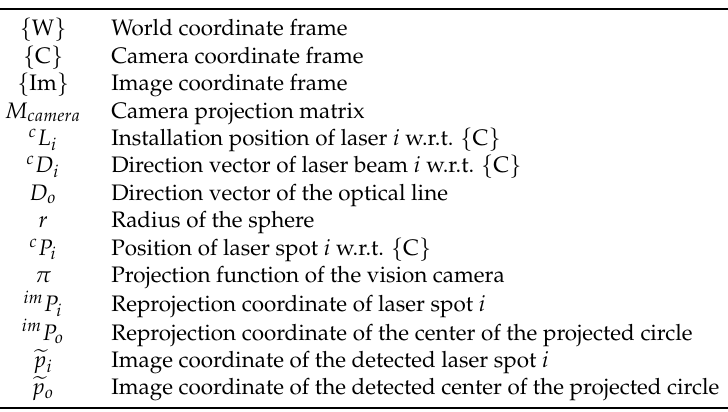
Figure 1. 3D model of the measurement system. Table 1. List of